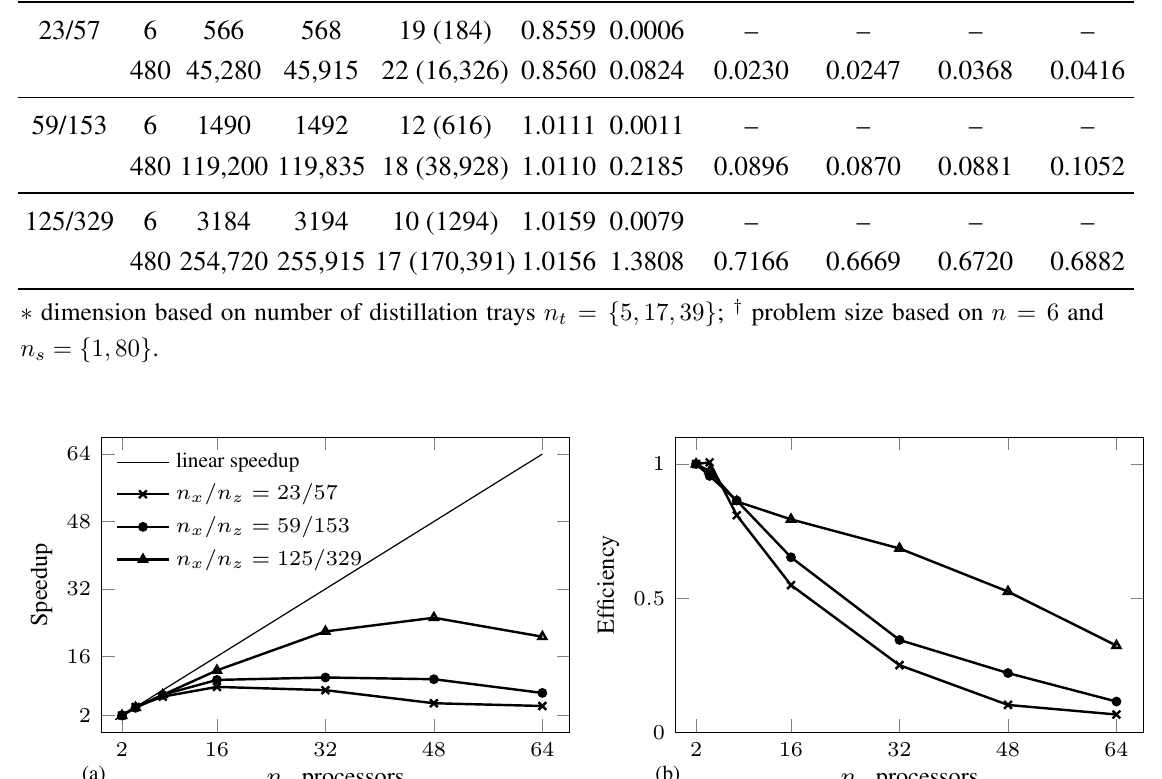
Figure 7. Case Study 2: speed-up and efficiency for increasing DAE size n n = 5 , 17 , 39 , with n = 6 , n t { }